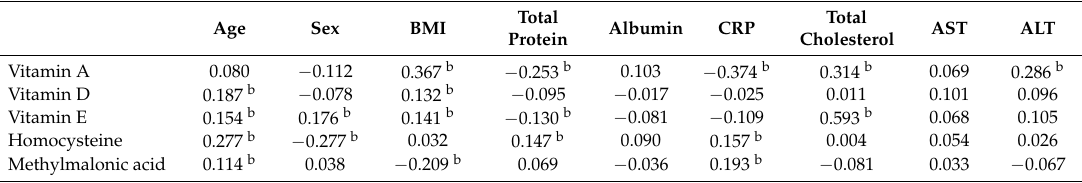
Table 3. Correlations among vitamin status, basal characteristics, and other biochemical test results of the study population a